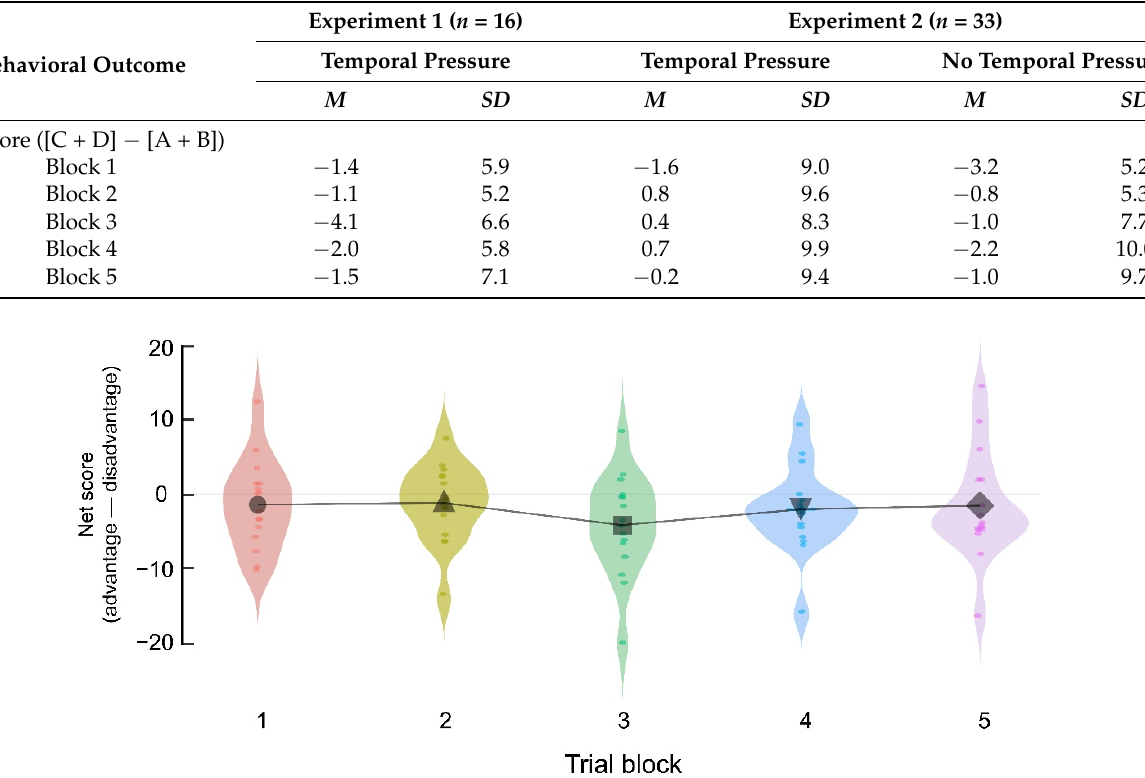
Figure 1 . Comparisons of the net scores (advantage (Decks C + D)—disadvantage (Decks A + B)) between the five trial blocks, each of which includes 20 trials in Experiment 1 ( n = 16). The net scores did not significantly change as the IGT progressed. Each dot represents the net score of each participant in each trial block. Black markers in the five blocks indicate mean net scores. Table 1. Behavioral results of the IGT in Experiments 1 and 2.